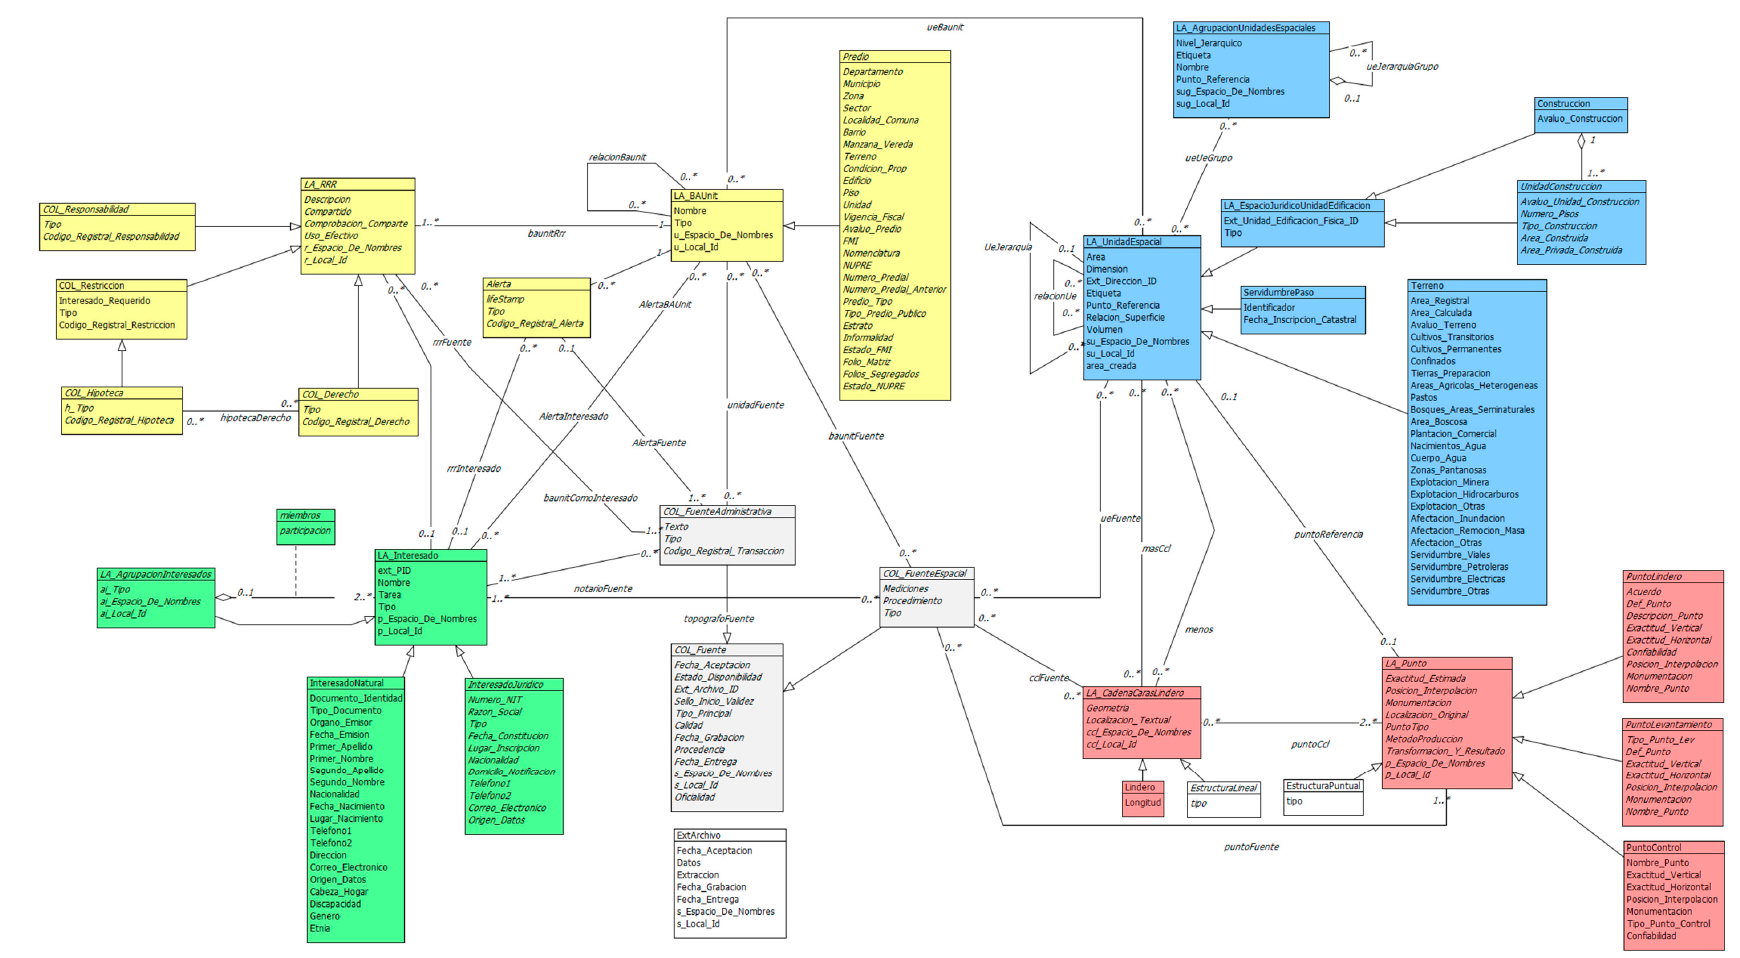
Figure 10. The UML of the COL_LADM profile.